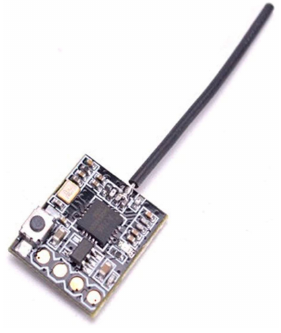
Figure 8. Remote control receiver used to trigger the sensor system.